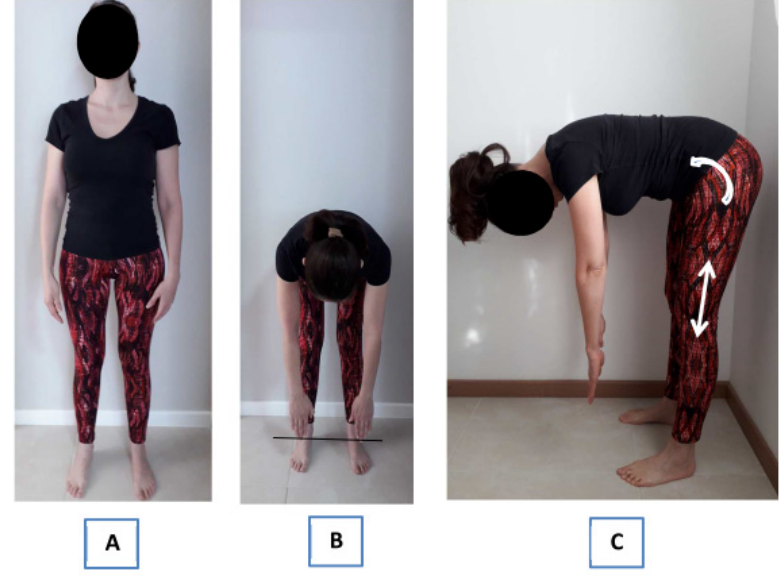
Figure 11. ( A ) The individual stands erect on the flood barefoot or with tennis shoes and, keeping the feet hip distance apart, bends forward as far as possible, while maintaining the knees, arms, fingers, and legs fully extended; ( B ) front view, with hands at the same level; and ( C ) lateral view, attention must be done to tilt the hip forward, feeling the stretching of the hamstring muscles to avoid rounding the back. The vertical distance between the tip of the middle finger and the floor is measured with a measuring